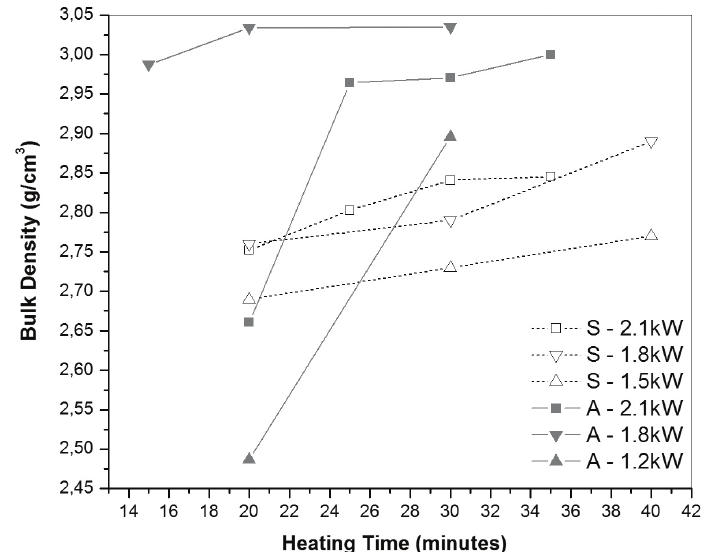
Figure 1. Density of samples sintered within a power range of 1.2 to 2.1